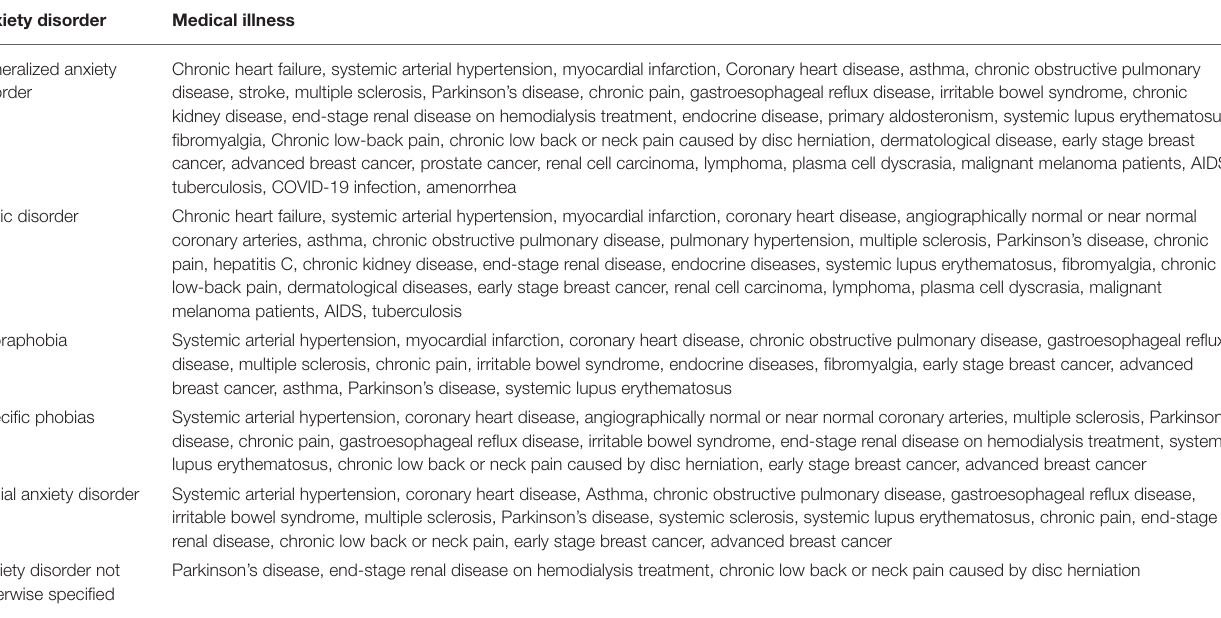
TABLE 2 | Anxiety disorders in medical